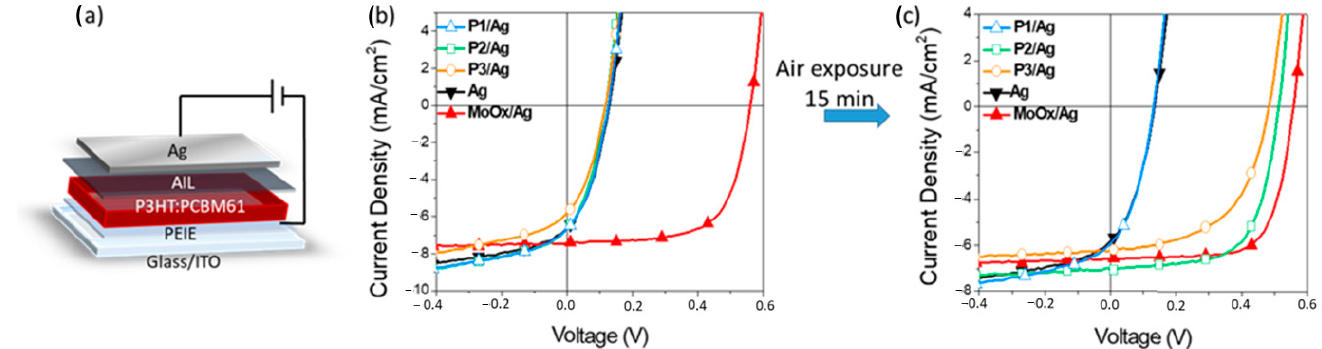
Figure 4. ( a ) Inverted devices architecture; ( b,c ) current density–voltage (J–V) curves under AM1.5 G irradiation at 100 mW/cm 2 . ( b ) before air exposure; and ( c ) after 15 min of air exposure.